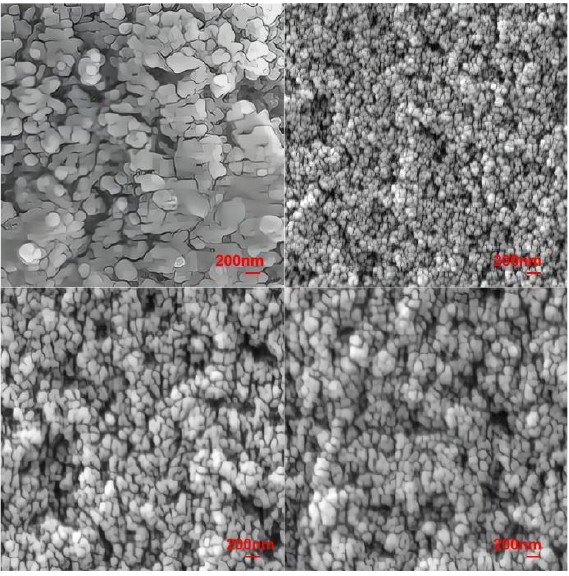
Figure 5. FESEM images of lithium aluminosilicate glass-ceramics.